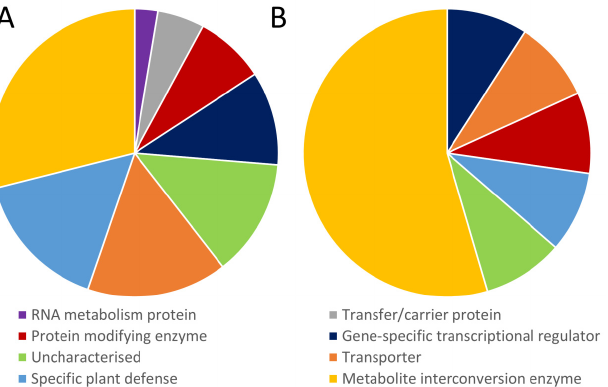
Figure 7. Functional annotations of common genes with changed regulation during stress crosstalk (heat, cold, drought, salinity; identified in Figure 4): ( A ) Protein classes represented in 38 common genes upregulated during stress crosstalk. ( B ) Protein classes represented in 11 common genes downregulated during stress crosstalk [240].